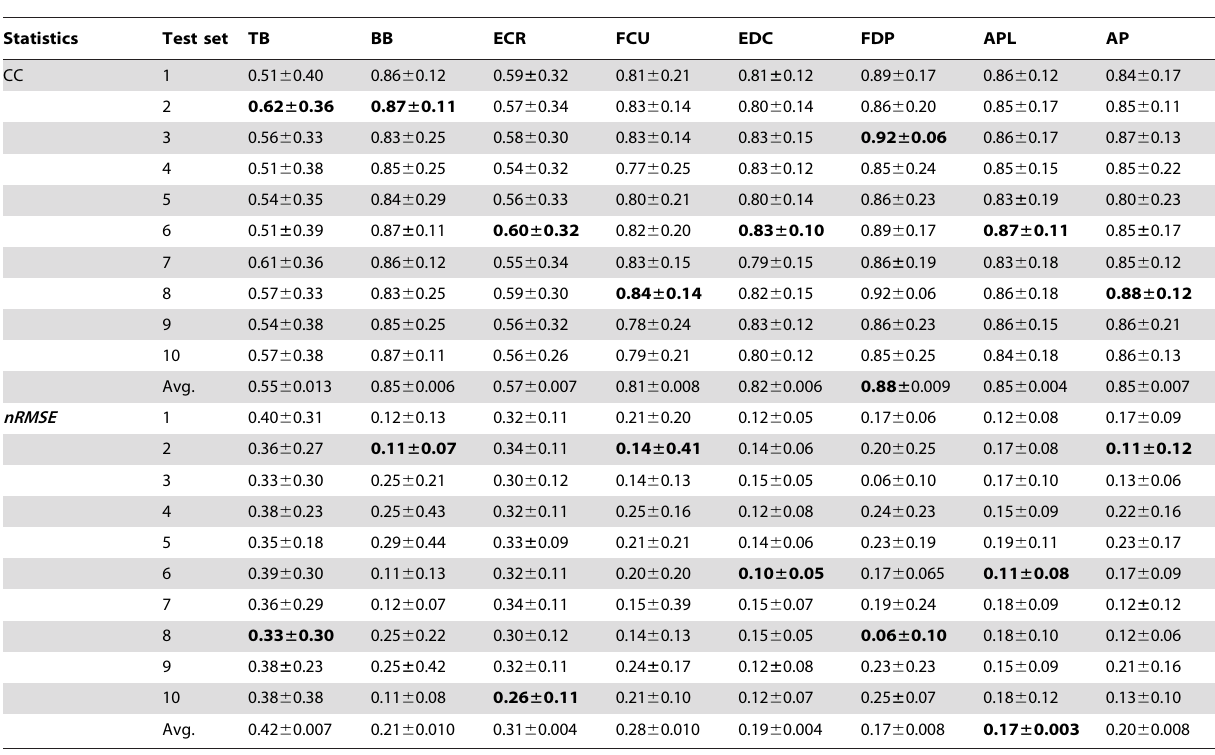
Table 1. Summary of prediction accuracies for 10-fold cross validation of monkey